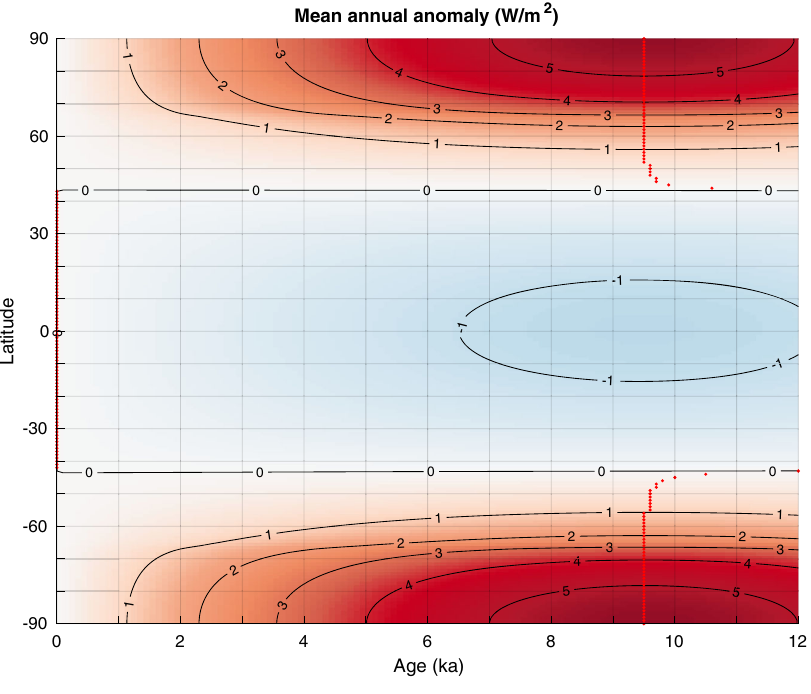
Fig. 10 | Mean annual insolation. Mean annual insolation anomaly compared to moderninsolation(W/m 2 )based onorbitalparameters 48 using theMatlabfunction